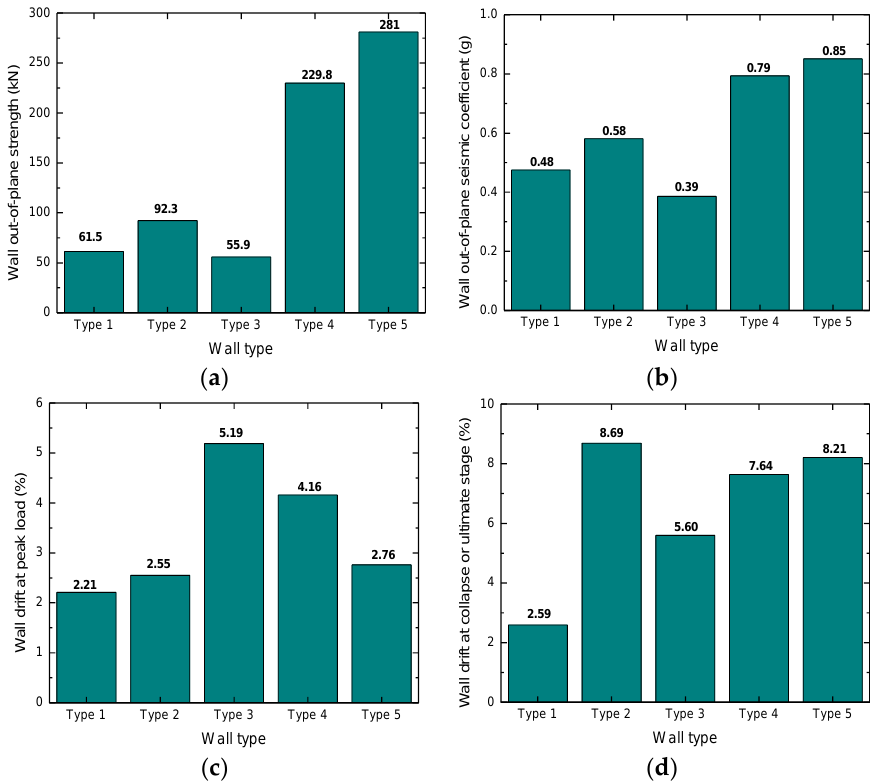
Figure 9. Structural performance assessment: ( a ) maximum strength; ( b ) seismic coefficient; ( c ) drift at peak load; ( d ) drift at near collapse or collapse stage.